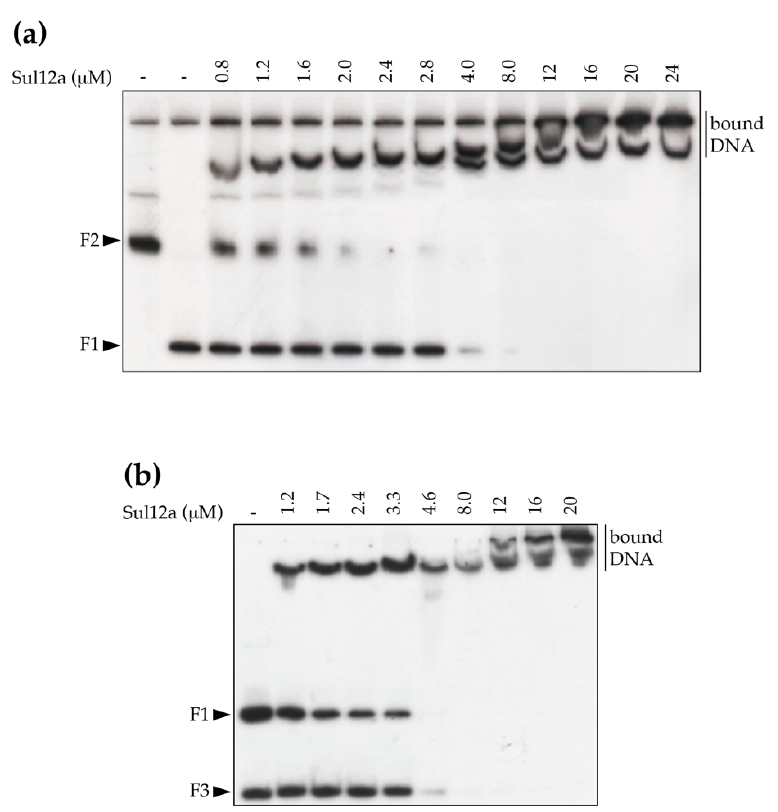
Figure 6. Competition in Sul12a binding for different DNA probes. EMSA were performed in the presence of a mixture of two radiolabeled probes: the ChIP-seq-enriched peak in the neighborhood of the Saci_1374 gene (F1) and a fragment representing the E. coli carAB promoter region (F2) ( a ) or a fragment representing the E. coli argO promoter region (F3) ( b ). Molar protein concentrations are indicated. Table 2. Apparent dissociation constants (K Dapp ) of Sul12a binding in the competition experiment (Figure 6). Fitted binding curves are shown in (Supplementary Figure S1).